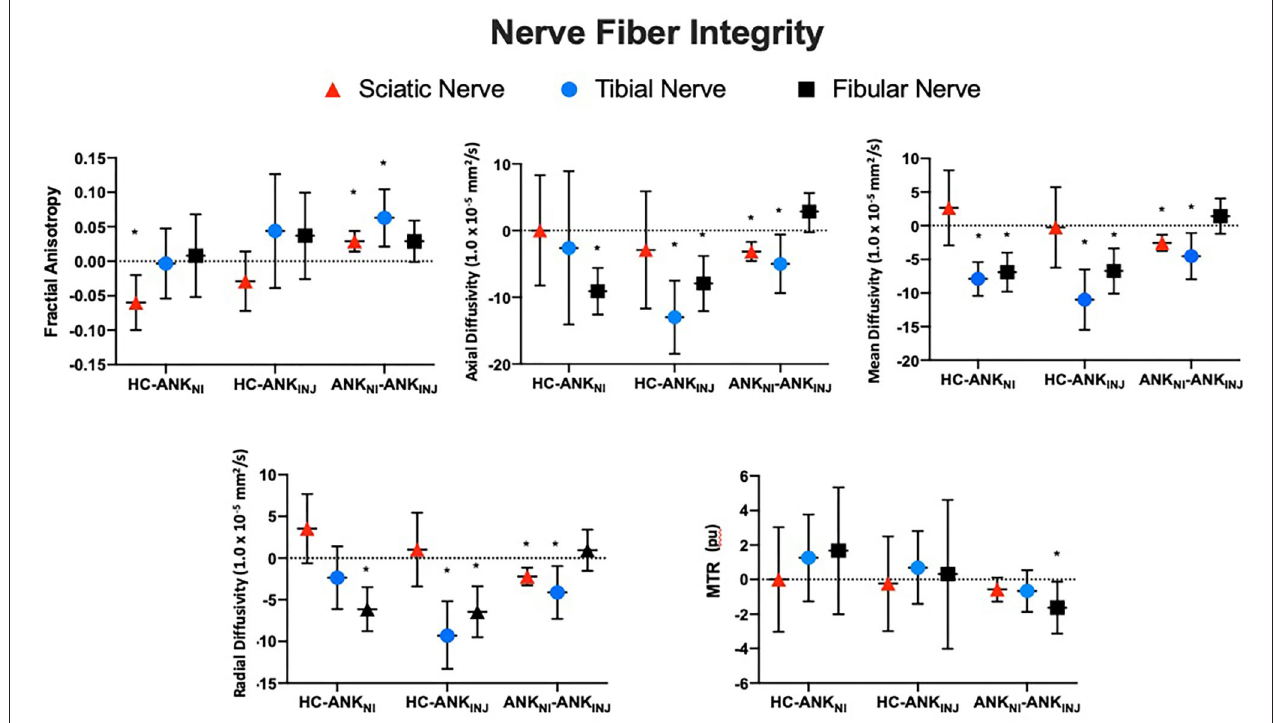
FIGURE 3 | Nerve fiber integrity using adjusted difference scores. Findings from the three nerve fiber divisions (Fibula, Tibia, Sciatic) are presented for each cohort (Healthy, Ankle – Injury, Ankle – No Injury) in terms of the within slice average values. Error bars reflect standard deviations. *Denotes statistical significance for the between group comparison. MTR, Magnetization Transfer Ratio Imaging; HC, Healthy Control; ANK NI , Ankle No Injury; ANK INJ , Ankle Injury.